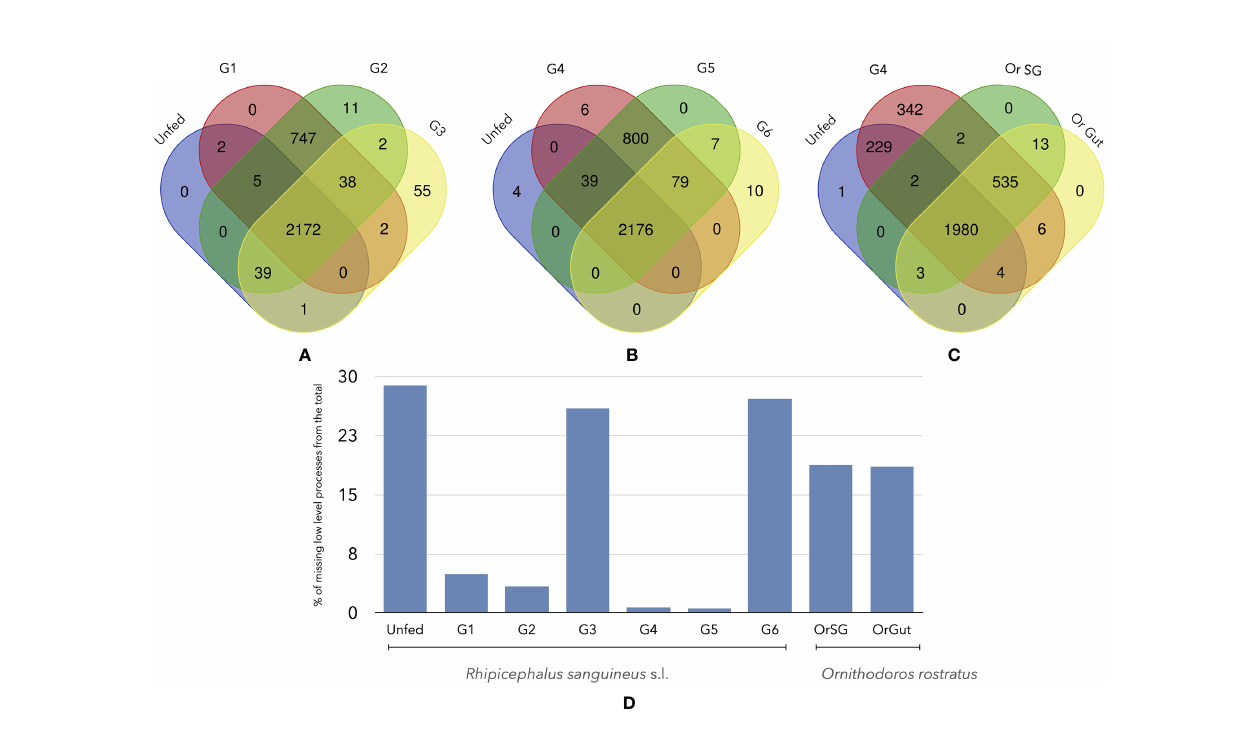
FIGURE 4 | Venn diagrams of the number of shared LL processes among different groups of unfed or fed R. sanguineus ticks and/ or O. rostratus . (A) R. sanguineus unfed, G1, G2, and G3; (B) R. sanguineus unfed, G4, G5, and G6; (C) R. sanguineus unfed, G4, and O. rostratus salivary glands or gut. The terminology of groups of feeding R. sanguineus follows Tirloni et al. (2020). The intersection of each diagram shows the number of shared proteins between these speci fi c groups. (D) Histogram show the quantity of processes that are non-present of the total of each tick